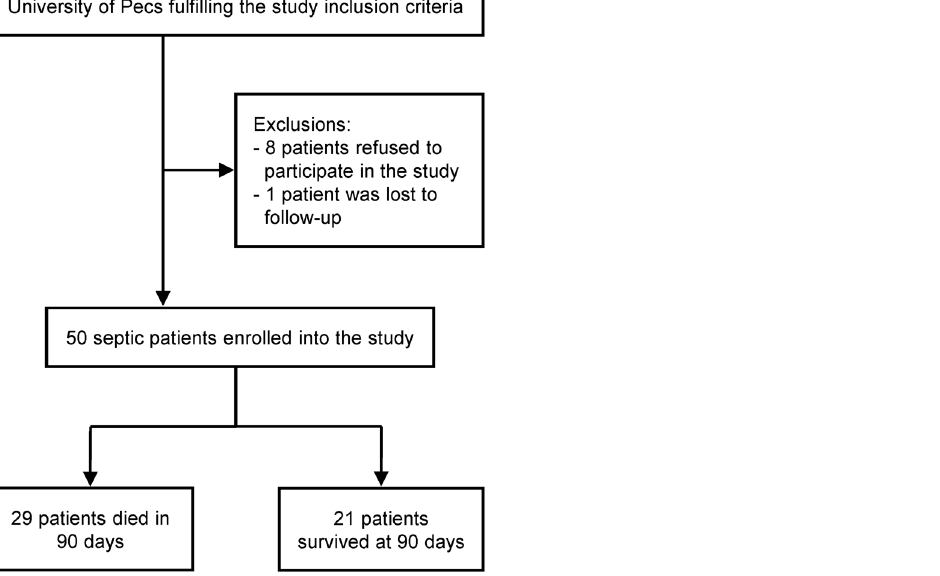
Figure 1. Flow diagram of the